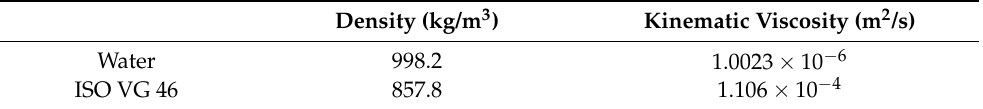
Table 3. Liquid mechanical properties.